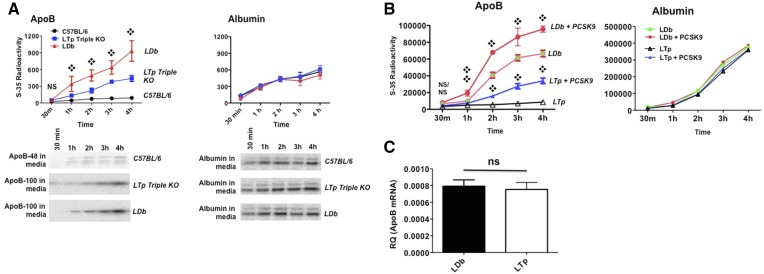
A: The apoB secretion rate is decreased in LTp triple KO mice deficient in PCSK9. Primary hepatocytes were isolated from C57BL/6J, LDb, and LTp mice. Cells were plated onto a 6-well plate coated with mouse type IV collagen. The next day, cells were labeled with 35S-methionine/cysteine for 30 min and chased for 30, 60, 120, 180, and 240 min. Cell media were immunoprecipitated with anti-mouse apoB (left) or anti-albumin (right) antibodies and protein A agarose, followed by SDS-PAGE. The bands of apoB100 (LDb and LTp mice) and apoB48 (C57BL/6J mice) were scanned using Typhoon FLA 7000 (GE) and quantified using Quantity One software (Bio-Rad). The results are expressed as total radioactivity in each band (mean ± SD). Statistical analyses were performed using two-tailed unpaired t-tests with Welch’s correction. ❖P < 0.05, comparing LDb to LTp mice. The experiments were performed three times with duplicate samples for each time point. The radioactivities of apoB were too low to detect in cell lysates. The radioactivities of apoB100 in C57BL/6 were too low to measure in cell media. A representative gel image is shown. B: Recombinant PCSK9 increased the apoB secretion rate in primary hepatocytes from LDb and LTp mice. Primary hepatocytes were isolated from LDb and LTp mice. Cells were plated onto a 6-well plate coated with mouse type IV collagen. The next day, the cells were incubated with 10 μg of recombinant PCSK9 for 4 h and the media were removed and washed. Next, the cells were labeled with 35S-methionine/cysteine for 30 min and chased for 30, 60, 120, 180, and 240 min. Cell media were immunoprecipitated with anti-mouse apoB (left) or anti-albumin (right) antibodies and protein A agarose, followed by SDS-PAGE. The bands of apoB100 (LDb and LTp mice) were scanned by Typhoon FLA 7000 (GE) and quantified using ImageQuant TL8.1 software (GE). The experiments were performed three times and the results are expressed as total radioactivity of each band (mean ± SD). Statistical analyses were performed using two-tailed unpaired t-tests with Welch’s correction. ❖P < 0.05, comparing LDb versus LDb incubated with PCSK9 and LTp versus LTp incubated with PCSK9. C: There is no significant difference in hepatic apoB mRNA levels between LDb and LTp mice. Hepatic apoB mRNA levels in LDb (n = 3) and LTp (n = 3) mice were determined using real-time quantitative RT-PCR. The results are presented as RQ (apoB mRNA normalized with 18S-RNA; mean ± SD). Statistical analyses were performed using two-tailed unpaired t-tests with Welch’s correction. The differences are not significant (ns).